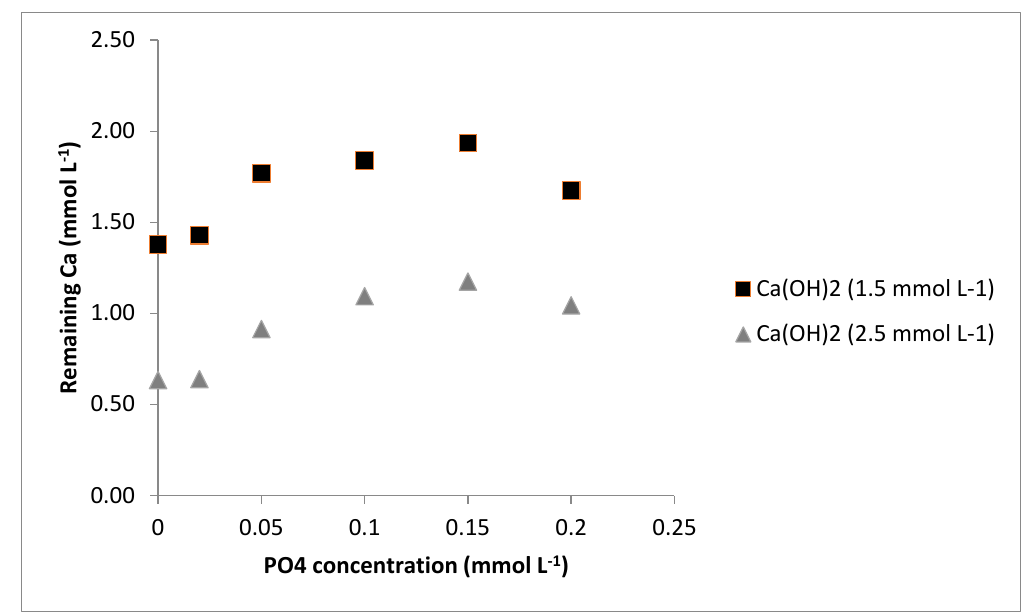
Figure 4. Inhibition effect of PO 43 − on precipitation of CaCO 3 .